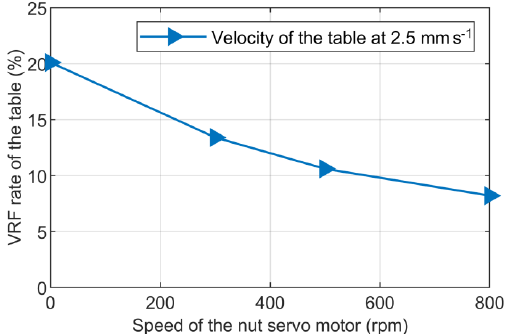
Figure 9. The VRF rate of the table varies with the speed of the nut servo